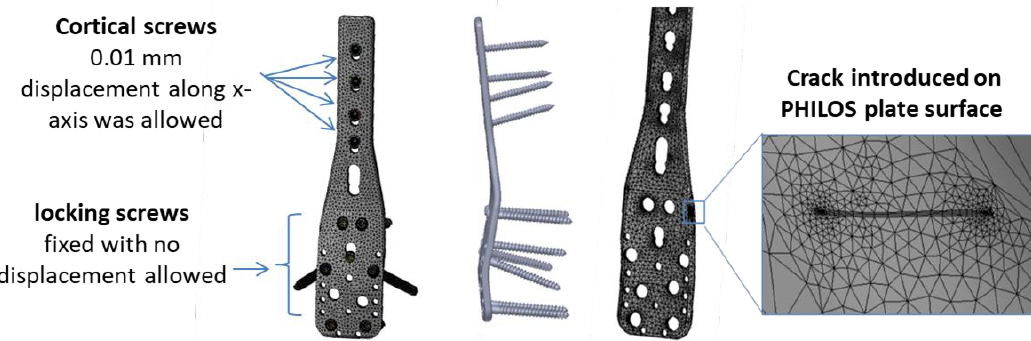
Figure 3. The PHILOS plate and crack meshing showing the locking and cortical nonlocking screw position and angle.